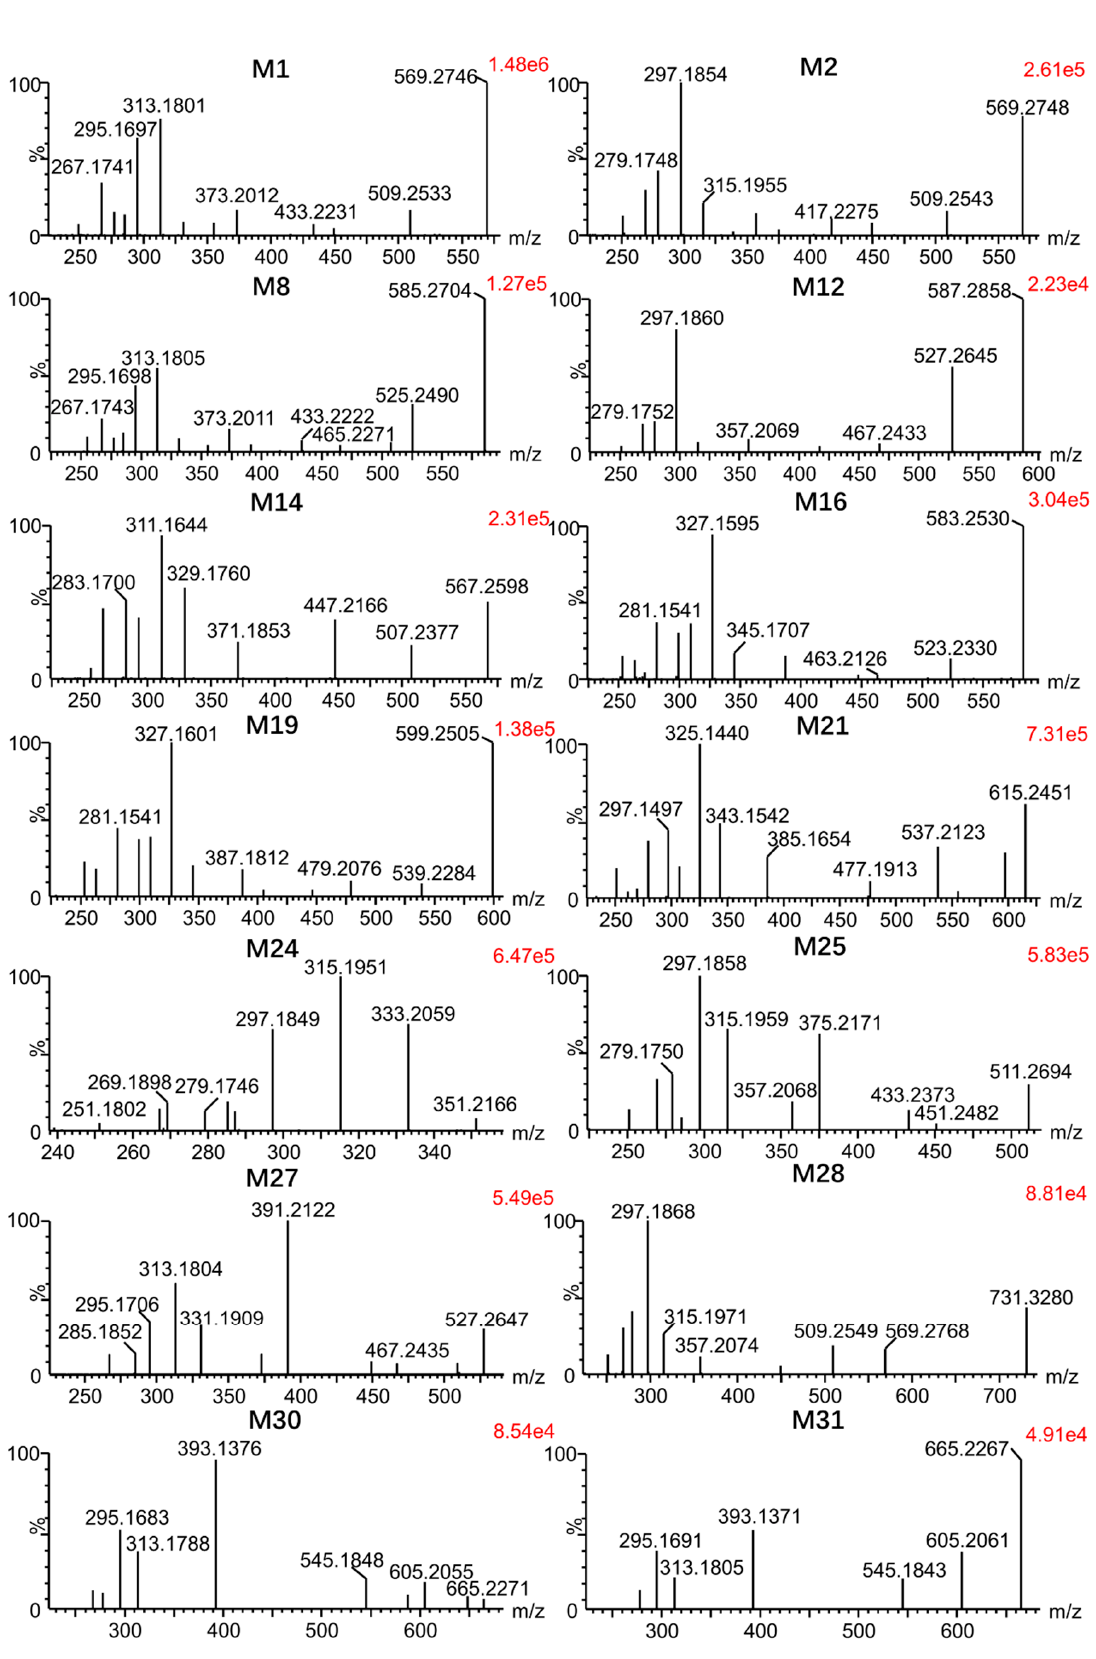
Figure 4. Product ion spectra of euphorbiasteroid metabolites in rats.